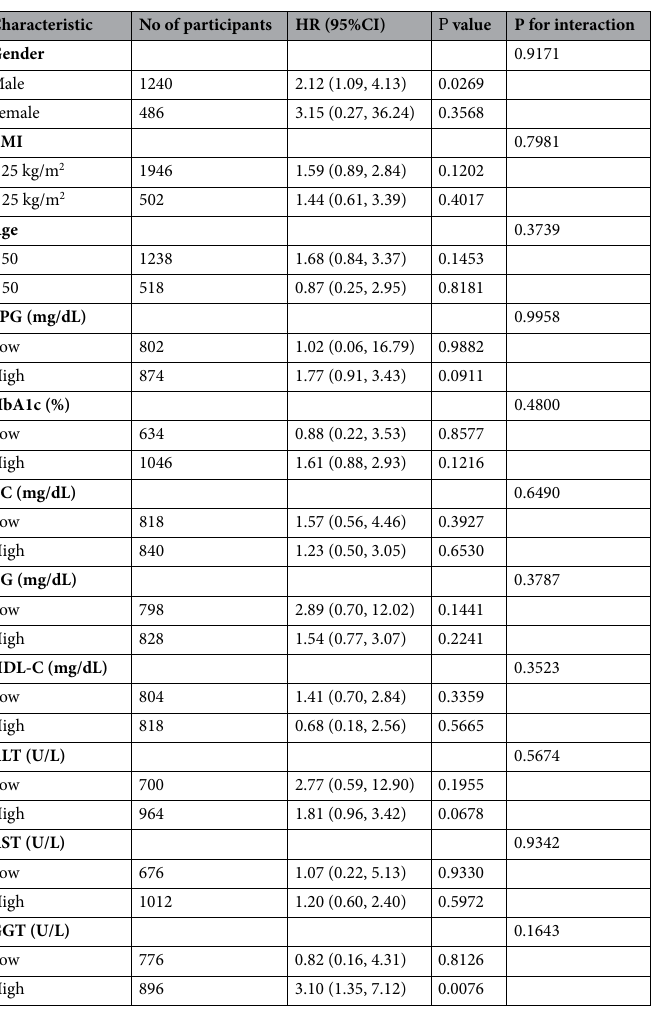
Table 4. Effect size of central obesity on incident diabetes in prespecified and exploratory subgroups. The above model has been adjusted for age, BMI, gender, smoking status, ethanol consumption, regular